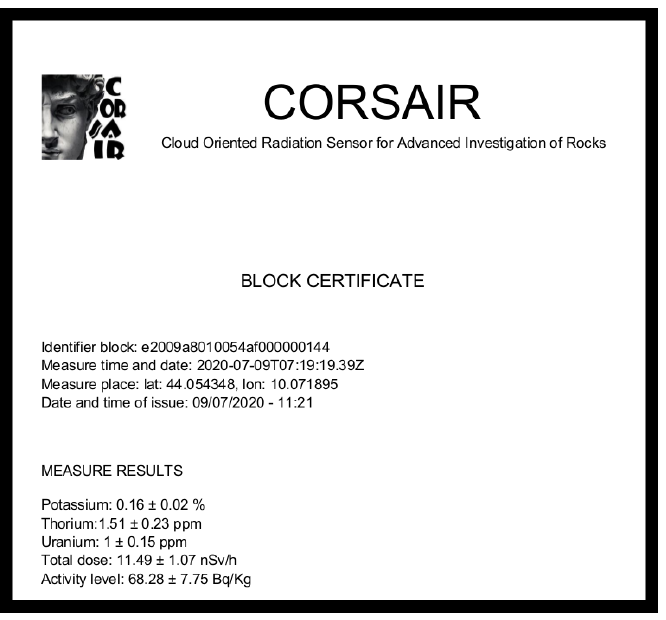
Figure 7. Material block certification generated by data gateway from company side.